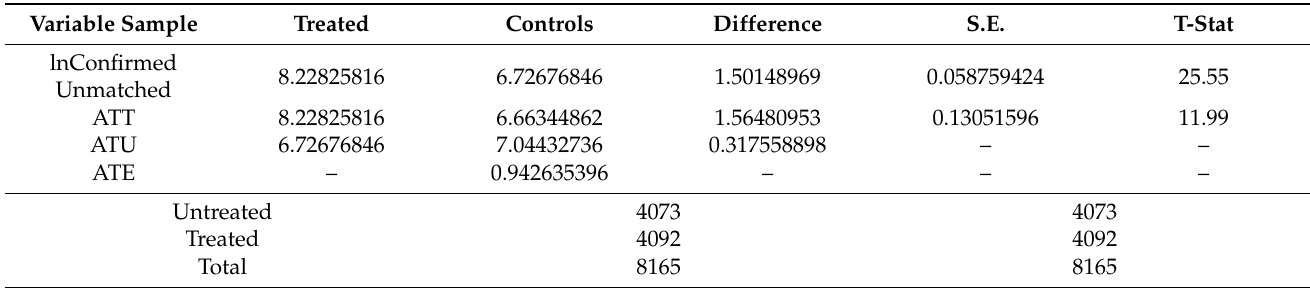
Table 5. Results of